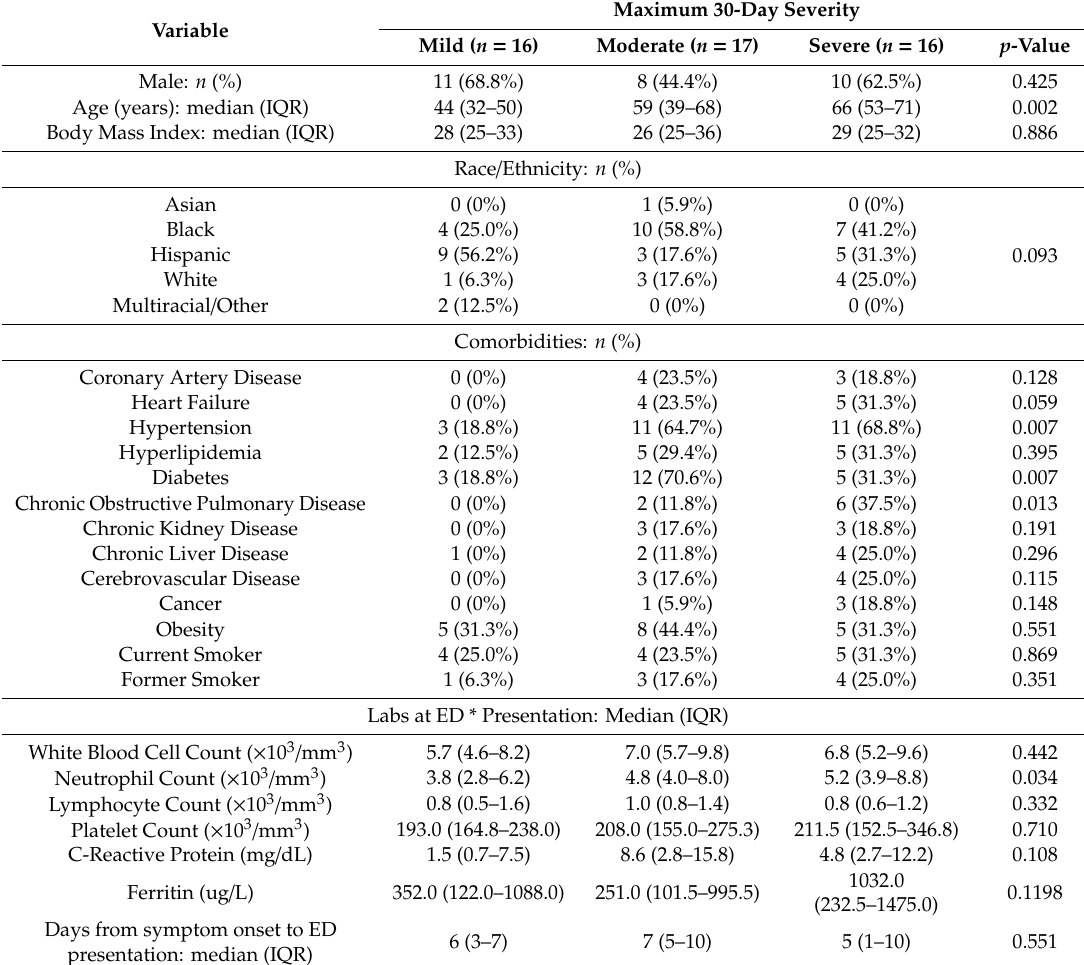
Table 1. Characteristics of Cincinnati COVID-19 Emergency Department Cohort ( n =